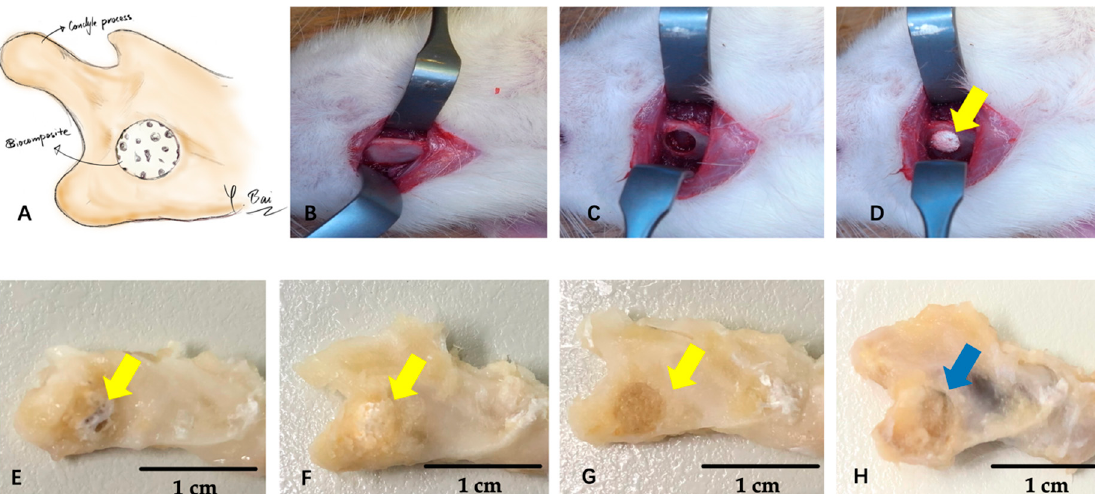
Figure 2. Flow diagram of the surgery and mandible specimens. ( A ) Relative position of the mandible and biocomposite. ( B ) Exposure of the right lateral mandible. ( C ) Creation of a critical defect. ( D ) Filling with different biocomposites. ( E ) Mandible with β -TCP/PDLLA. ( F ) Mandible with β -TCP. ( G ) Mandible with PDLLA. (H) Mandible with defect only. ( E – H ) All photographs depict the 2-week postoperative group. Yellow arrow indicates the biocomposite. Blue arrow indicates the defect. Scale bar: 1 cm. The materials in E–H were only used for demonstration purposes, and were not included in the micro-computed tomography (micro-CT) or staining experiments.